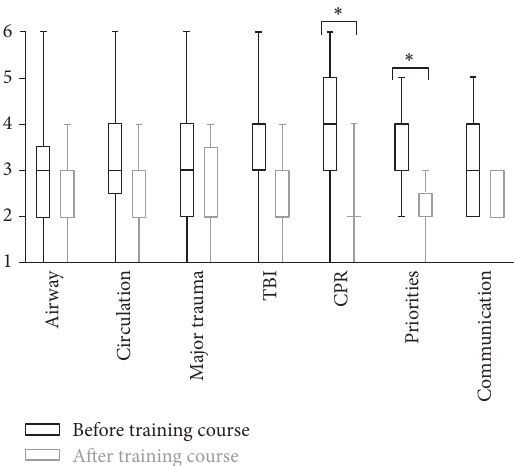
Figure 1: Assessment of various elements of the course pre- and posttrauma training (1 = very good, 6 = unsatisfactory, median, 25th and 75th percentiles, and span). ∗ 𝑝 < 0.001